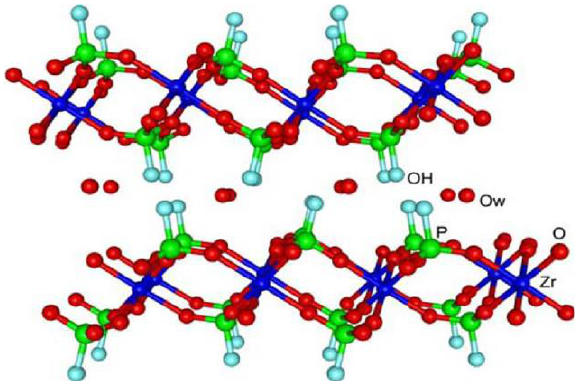
Figure 1. The crystalline structure of α -ZrP. Reprinted with permission from reference [14].